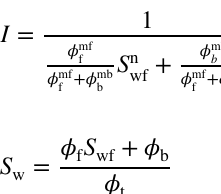
Fig. 8 Physical model of the dual-pore component rock physical vol-